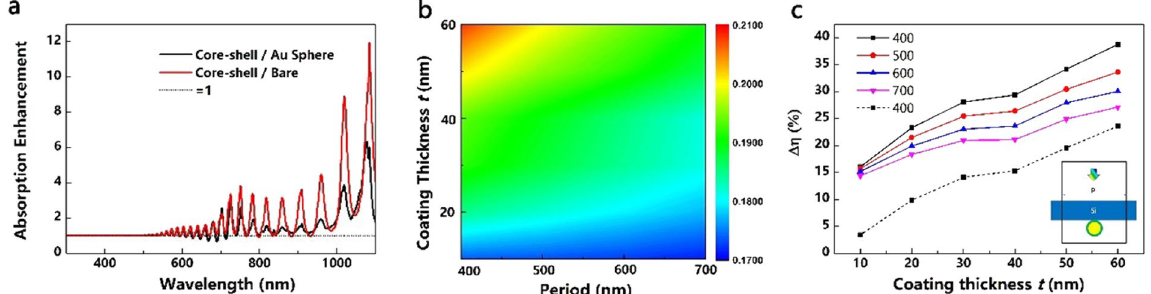
Figure 6. Optical properties and ultimate efficiencies of core-shell nanoparticles with different t placed on the rear side of the 2 μ m thick Si substrates with different P . The inner Au core is 120 nm and the n is set as 3.4. ( a ) Absorption enhancement factor of core-shell nanoparticle when compared with the 2 μ m thick Si with 120 nm Au sphere and a flat cell ( P = 400 nm, t = 60 nm). ( b ) Ultimate efficiency of core-shell nanoparticles on the 2 μ m thick Si. ( c ) Differential efficiency ∆ η between the core-shell nanoparticles on a 2 μ m flat Si and a 2 μ m flat Si without nanoparticles. The dashed line is the differential value between the core-shell nanoparticles on a 2 μ m thick Si and a 120 nm Au sphere on a 2 μ m thick Si and the P is set as 400 nm; the inset is the schematic in simulation.